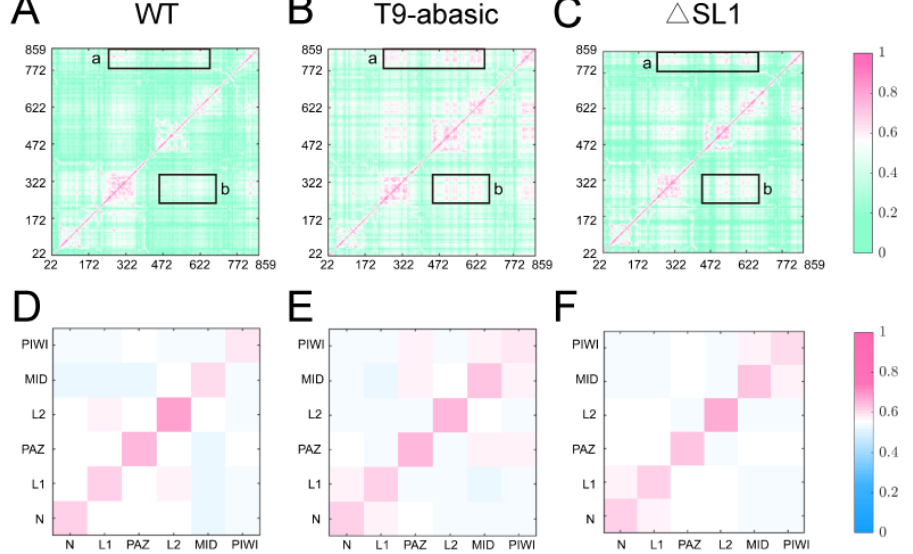
Figure 5. Inter-residue and inter-domain correlation of the Ago2 protein. Generalized residue correlation of the WT system ( A ), the T9-abasic system ( B ) and the ∆ SL1 system ( C ). The significant correlation differences are highlighted with a rectangle in each panel. Generalized domain correlation of the WT system ( D ), the T9-abasic system ( E ) and the ∆ SL1 system ( F ).